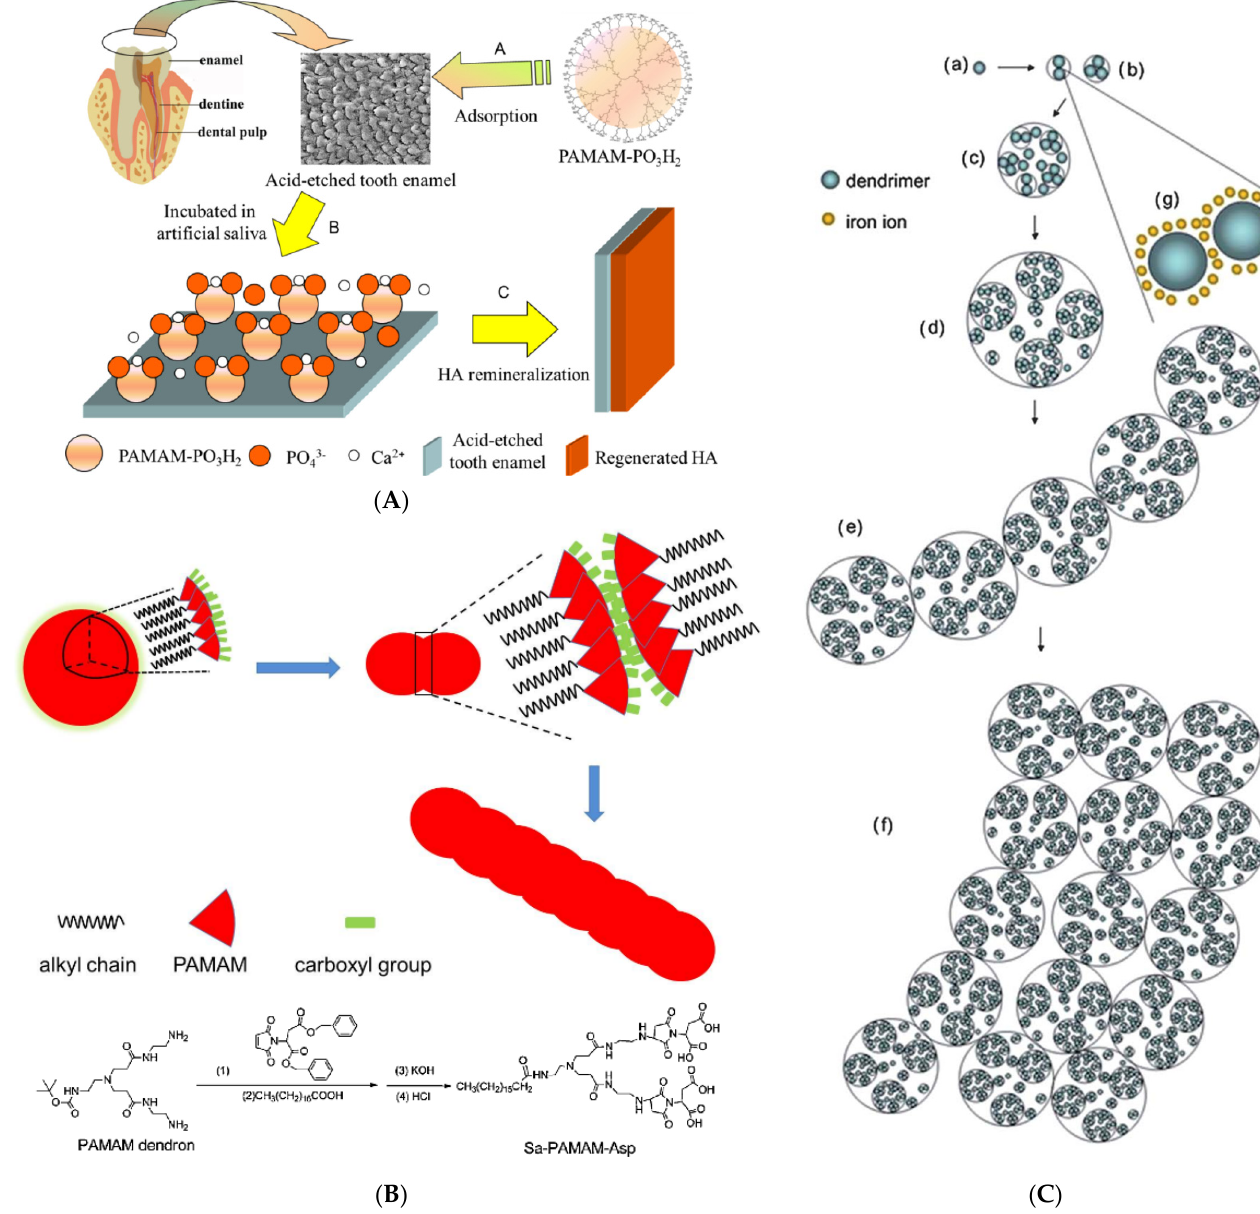
Figure 25. ( A ) Schematic demonstration of the adsorption of PAMAM-PO 3 H 2 on the surface of tooth enamel and the subsequent in situ remineralization of hydroxyapatite. Reproduced under permission from [249]. ( B ) The modification of PAMAM dendron with aspartic acid-stearic acid and schematic illustration of the linear chain aggregation of the nanospheres. Reproduced with permission from [250]. Copyright: ROYAL SOCIETY OF CHEMISTRY ( C ) Schematic illustration of the self-assembly process of G4.0-COOH PAMAM. ( a ) The single G4.0-COOH PAMAM dendrimer molecule is a globular unit. R h = 4.4 nm. ( b , c ) Oligomers of G4.0-COOH PAMAM dendrimers. R h = 6–10 nm and 40–80 nm for different stages. ( d ) Nanosphere structures are formed through the association of oligomers and monomers. R h = 160–200 nm. ( e ) Further association of nanospheres results in a larger assembly to form nanosphere chains. ( f ) The organization of the nanosphere chain forms a microribbon structure. ( g ) Interconnection of G4.0-COOH PAMAM dendrimers by iron ion chelation. Reproduced with permission from [251]. Copyright: Royal Society of